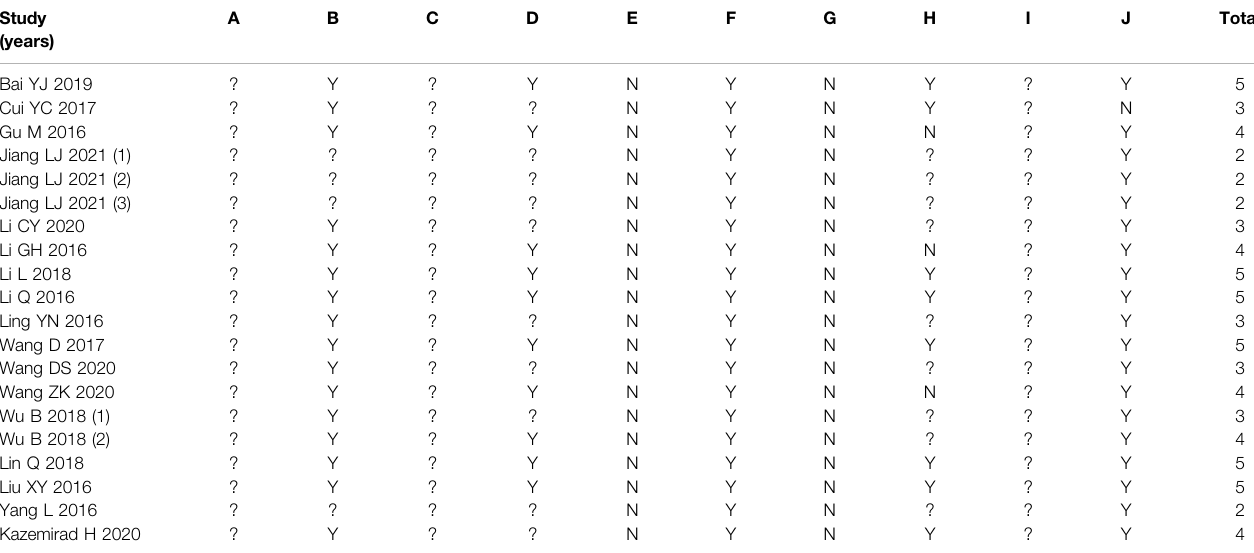
TABLE 3 | Quality assessment of included studies.